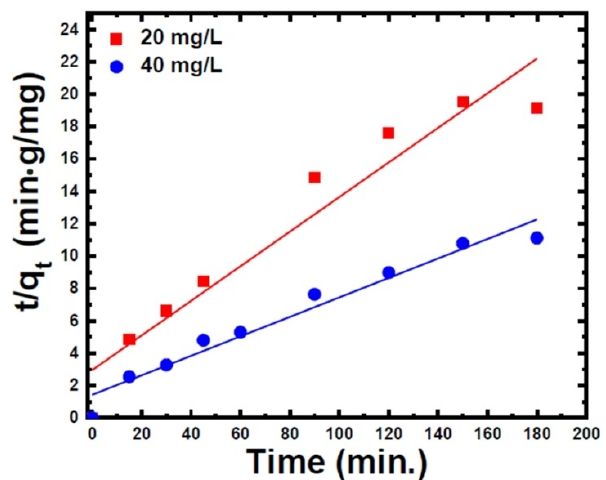
Figure 7. Pseudo-second-order kinetic model (t/ q t versus time) for CR dye adsorption on the ZnS nanoparticles.